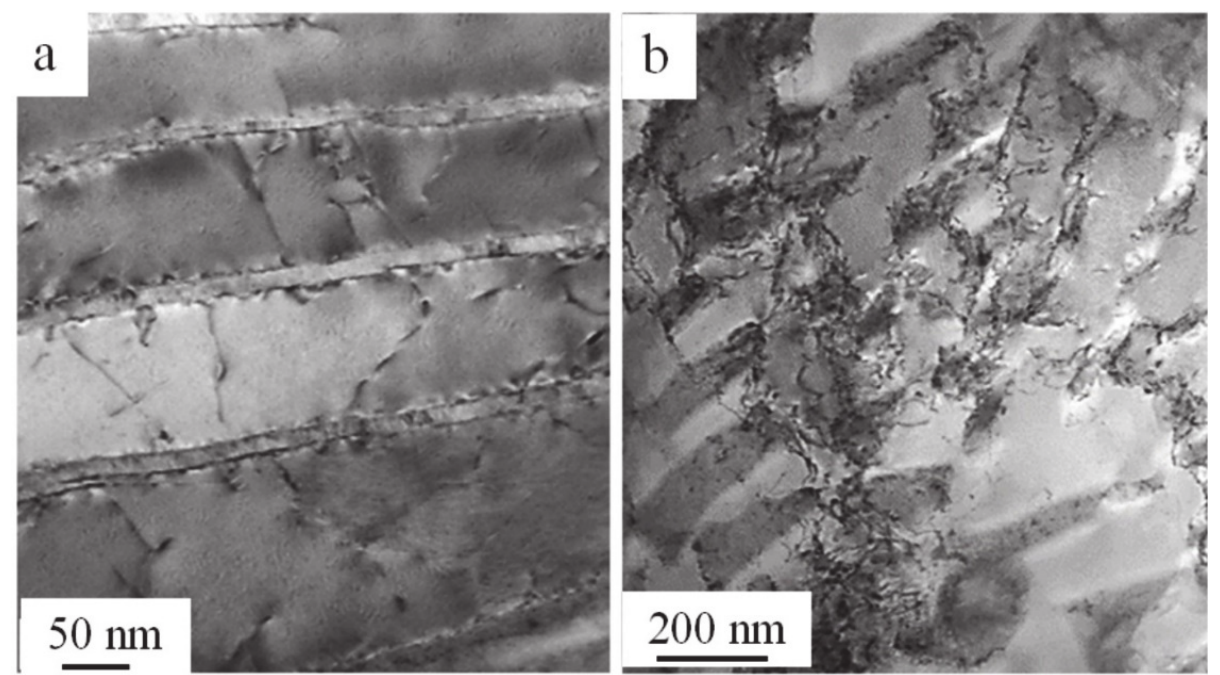
Figure 5. A TEM image of the steel dislocation substructure in the initial state ( a ) and after the compressive deformation at ε = 50% ( b ).